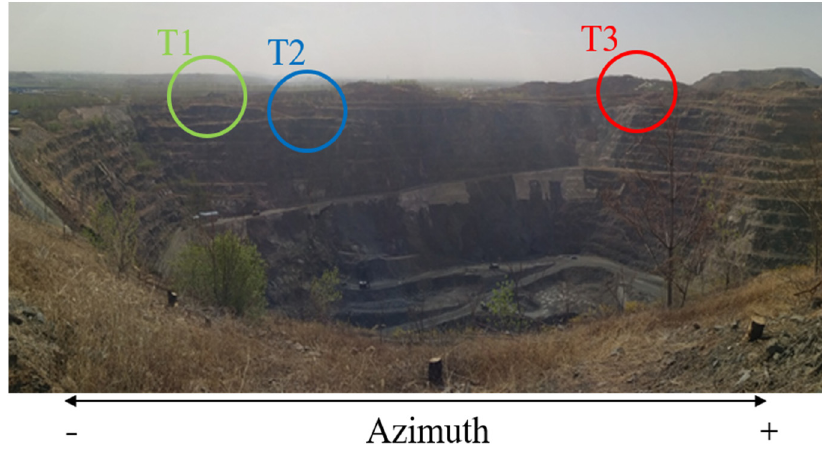
Figure 10. The scene of the experiment.